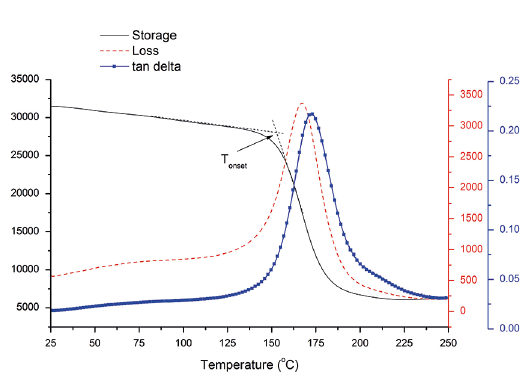
Figure 1. Storage modulus, loss modulus and tan δ curves for carbon NCF/epoxy composites produced by